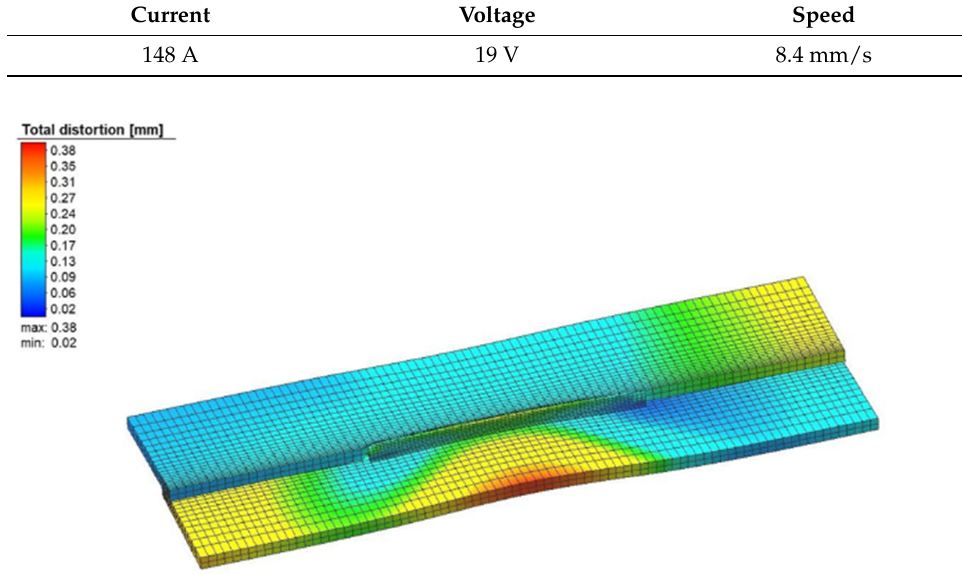
Figure 10. Maximum distortion using optimum weld